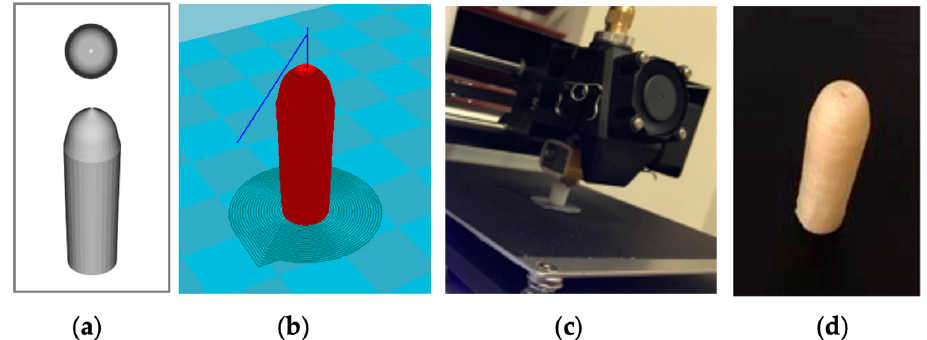
Figure 1. The 3D printing of a hollow suppository shell with an orifice: ( a ) Computer-aided design (CAD) of a suppository shell (top and side); ( b ) stereolithography (STL) image for 3D printing; ( c ) 3D printing of a polyvinylalcohol (PVA) shell; ( d ) a 3D-printed hollow suppository shell with an orifice on top.